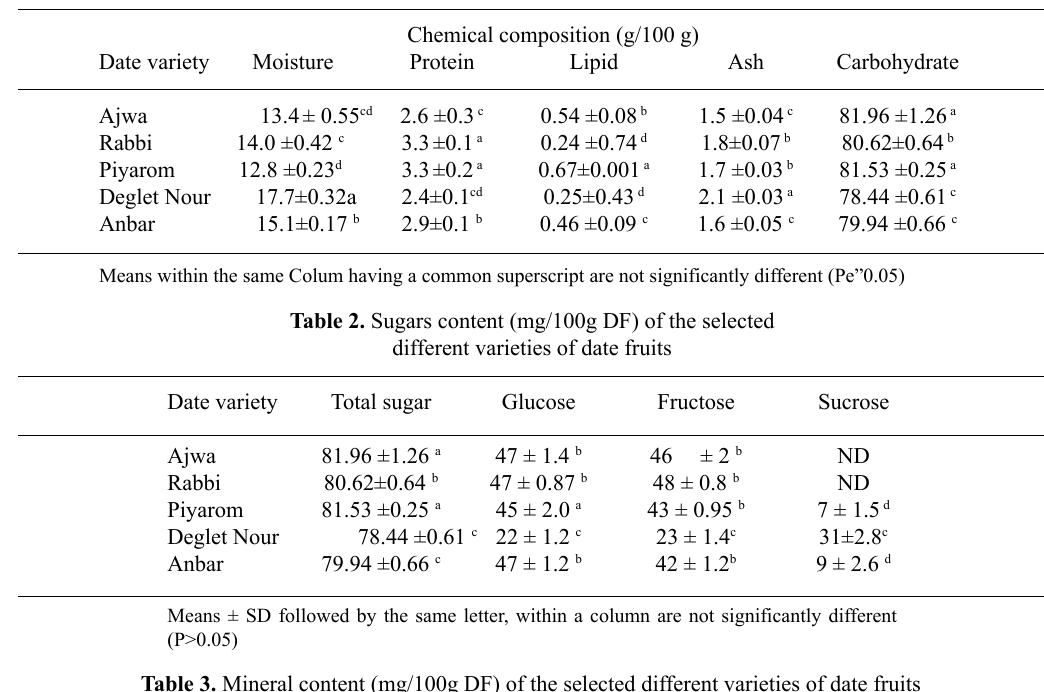
table 1. Chemical composition of different date varieties